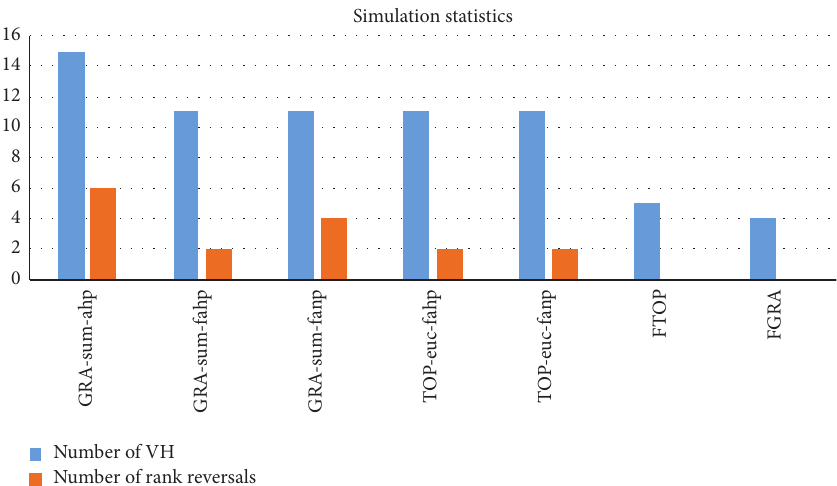
Figure 6: Numbers of VHs and rank reversals performed during the simulation using each